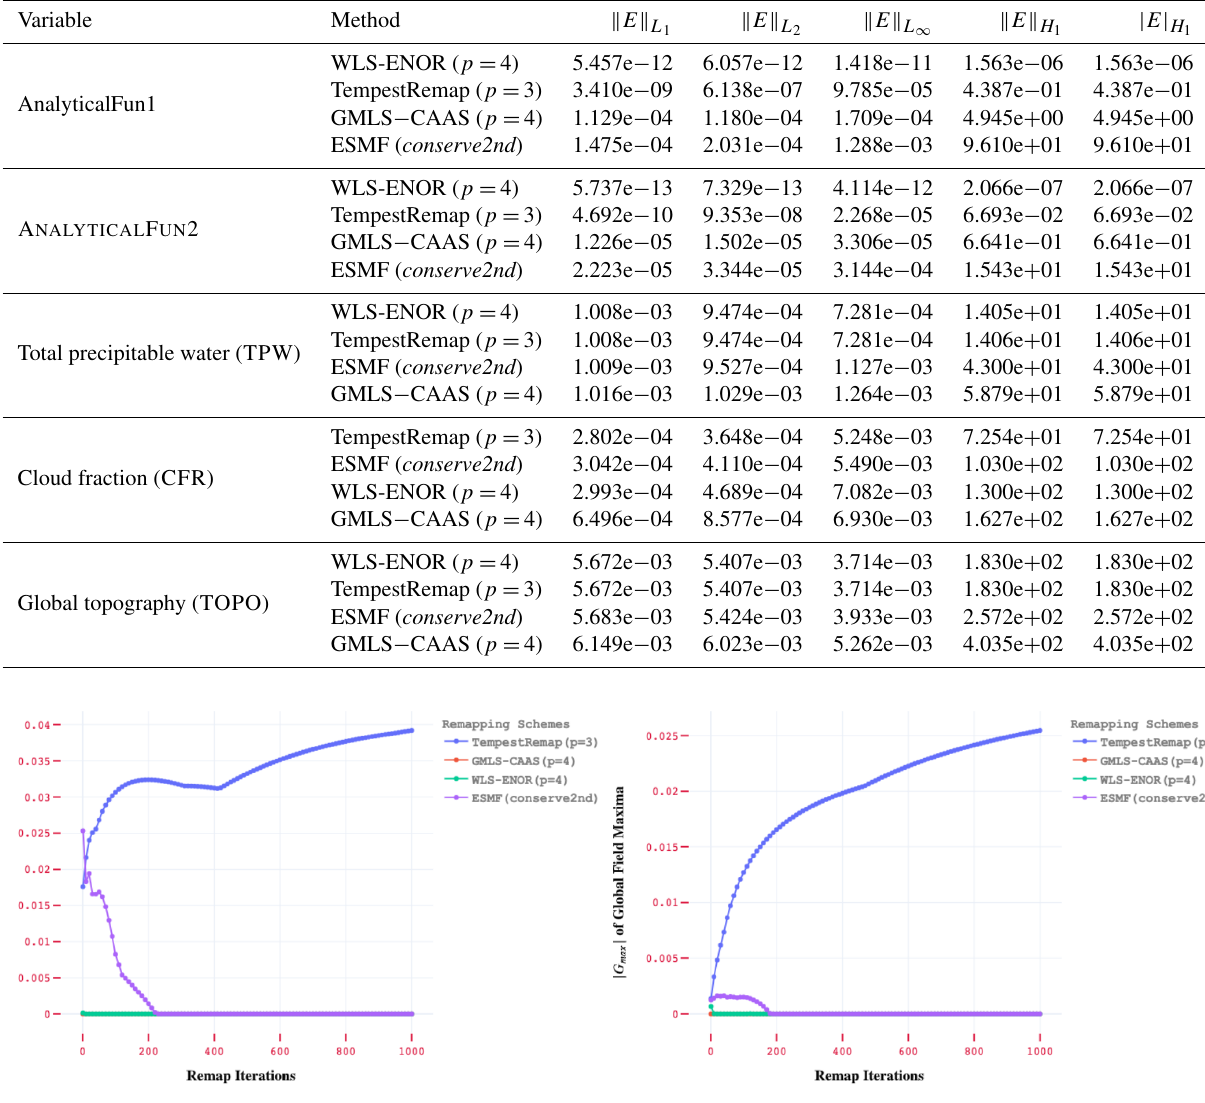
Table 7. Comparison of global error norm metrics for different remap schemes on the finest (r2) CS-MPAS RRM combination, ordered from error for all field variables. best to worst in terms of (cid:107) E (cid:107) L 2